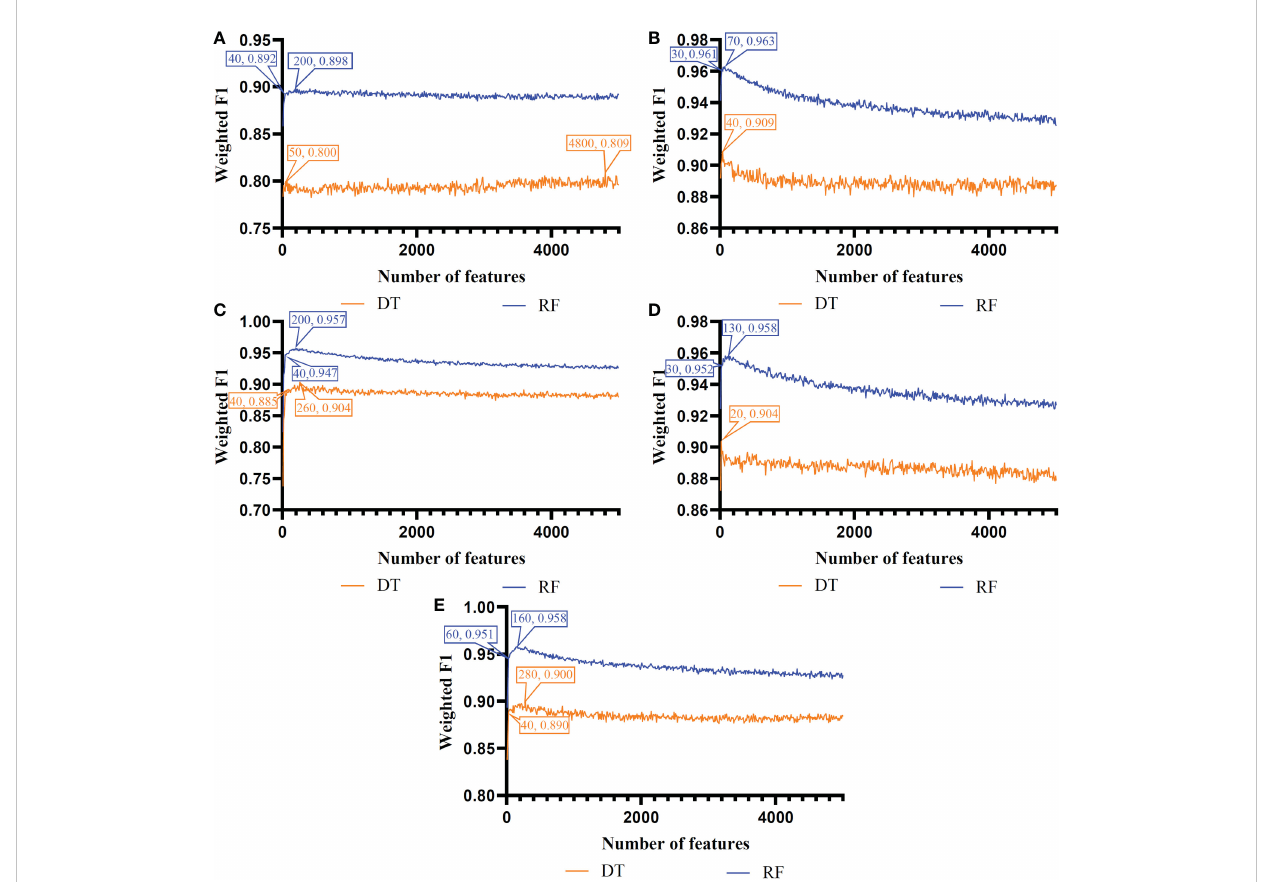
FIGURE 4 Incremental feature selection (IFS) curves of two classi fi cation algorithms in CD4 + T cells. (A) IFS results obtained based on the LASSO gene list. (B) IFS results obtained based on the LightGBM gene list. (C) IFS results obtained based on the mRMR gene list. (D) IFS results obtained based on the MCFS gene list. (E) IFS results obtained based on the PFI gene